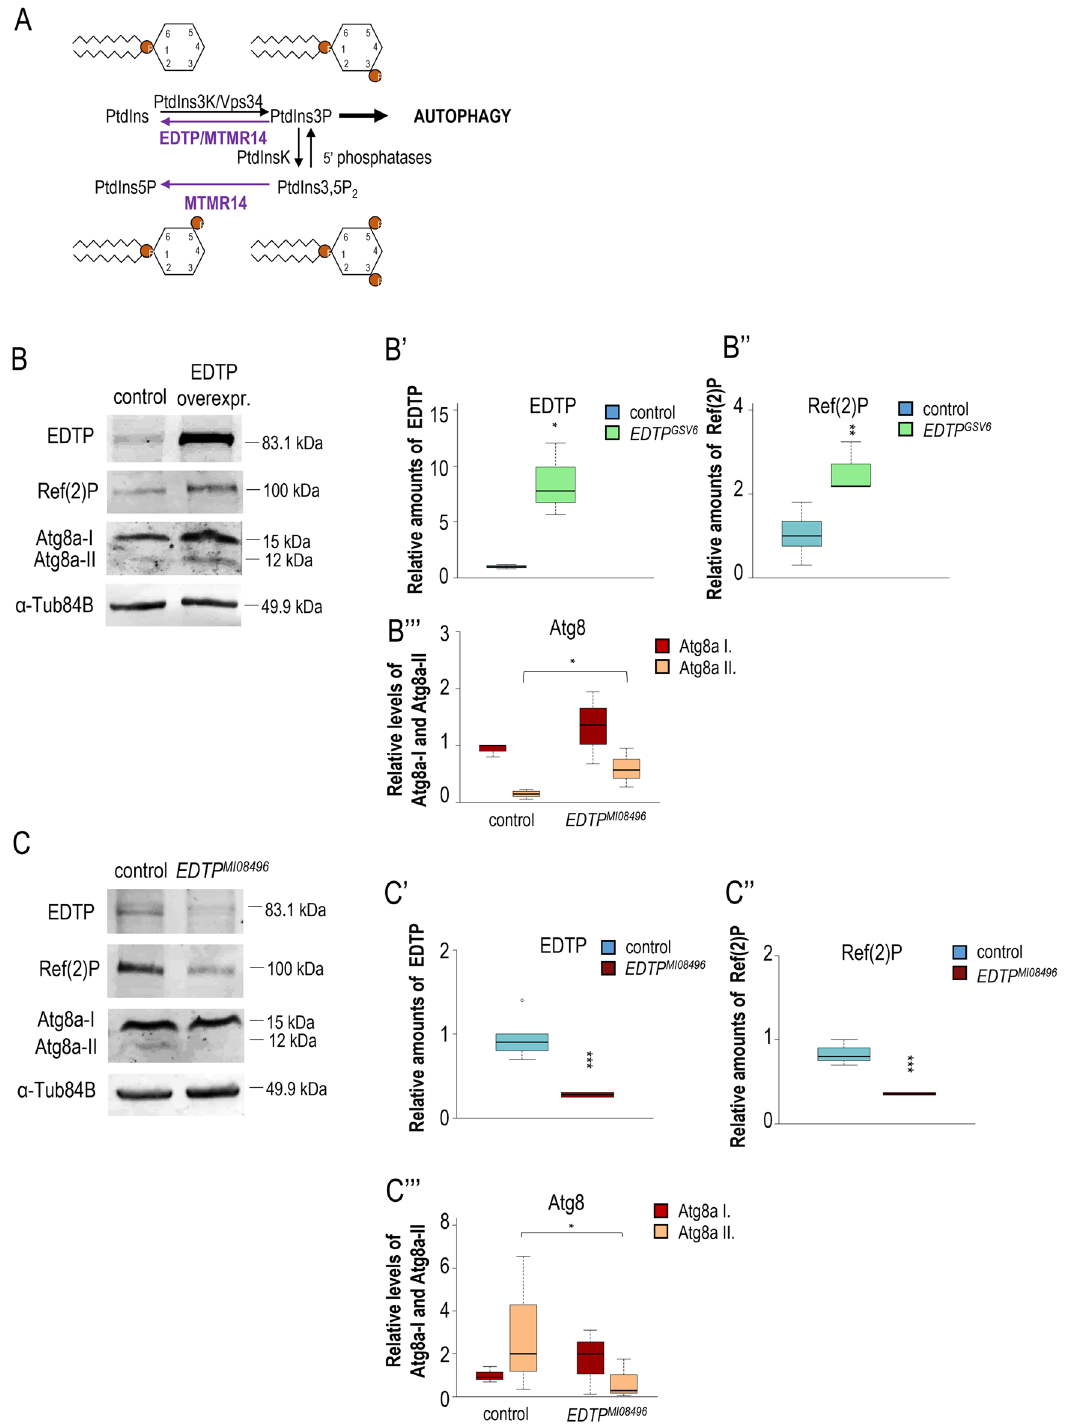
Figure 2. EDTP hyperactivity inhibits, while EDTP deficiency enhances, autophagic activity in the Drosophila brain. ( A ) Enzymatic function of Drosophila EDTP and mammalian MTMR14 lipid phosphatases. The two proteins convert PI3P into PI, thereby antagonizing autophagic membrane formation. ( B ) Western blot analysis demonstrates elevated levels of EDTP and Ref(2)P in an genetic background overexpressing EDTP as compared to control. The autophagic membrane-conjugated form of Atg8a (Atg8a-II) also increases relative to Atg8a-I, which represents the soluble (non-conjugated) form of Atg8a. ( B ′ –B ‴ ) Quantification of relative EDTP, Ref(2)P, Atg8a-I and Atg8a-II levels, determined by the western blot analysis ( B ). ( C ) Western blot analysis reveals that relative levels of EDTP, Ref(2)P and Atg8a-II/Atg8a-I ratio each decrease in an EDTP defective (hypomorphic mutant) genetic background relative to control. ( C ′ –C ‴ ) Quantification of relative EDTP, Ref(2)P, Atg8a-I and Atg8a-II densities identified by the western blot analysis ( C ) . In panels B and C, proteins were extracted from the head of female fruit flies, αTub84B was used as an internal control, and animals were maintained at 29 °C. On the plot the boxes represent the most typical 50% of the samples, the line indicates the median, upper and lower whiskers show remaining 25–25% of the samples. Circles mark outliers. * P < 0.05; ** P < 0.01; *** P < 0.001. For statistics, see the “Materials and